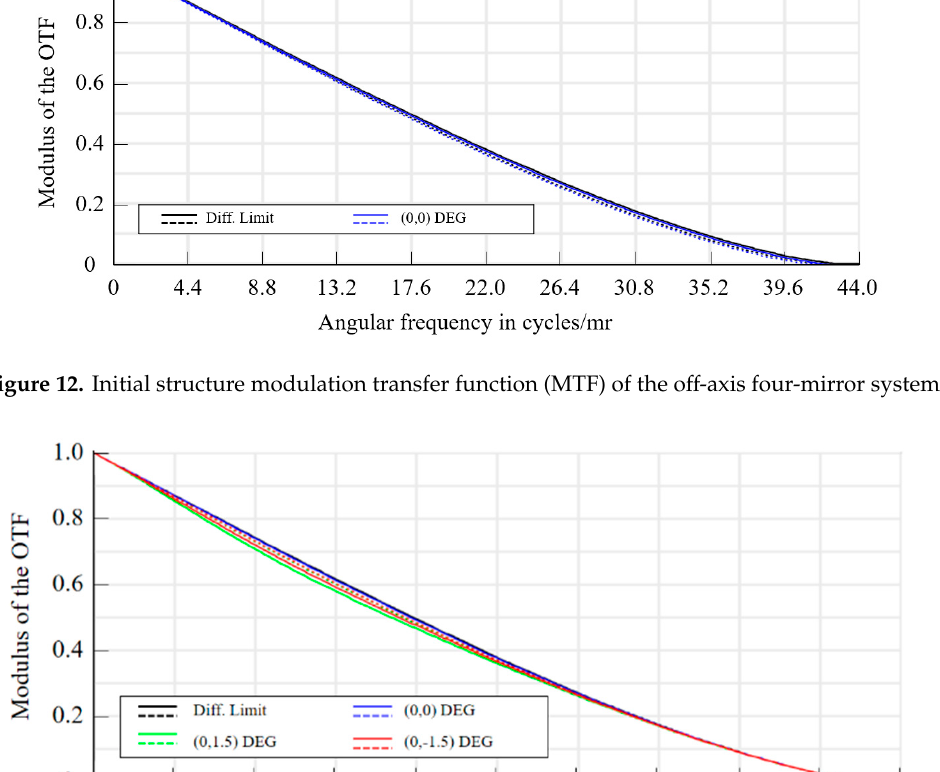
Figure 13. Optimized structure MTF of the off-axis four-mirror system.